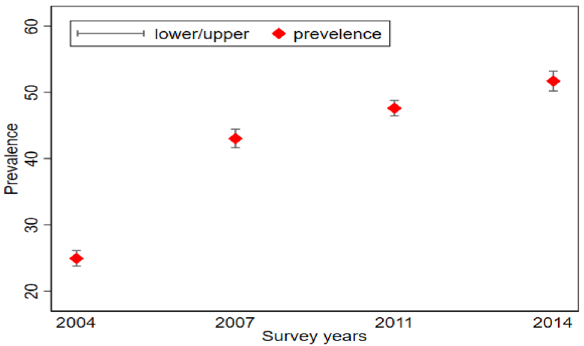
Figure 1. Prevalence of EIBF with confidence interval from BDHS